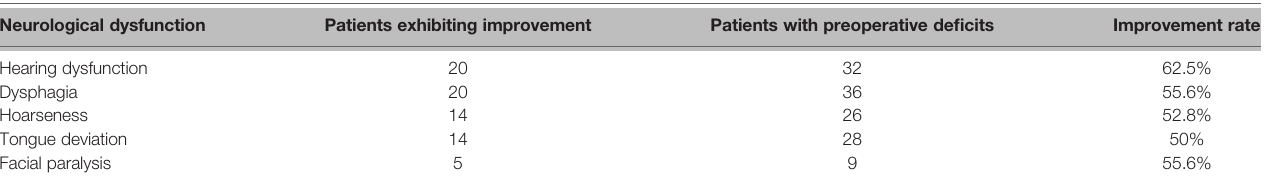
TABLE 3 | Postoperative improvements in neurological function during